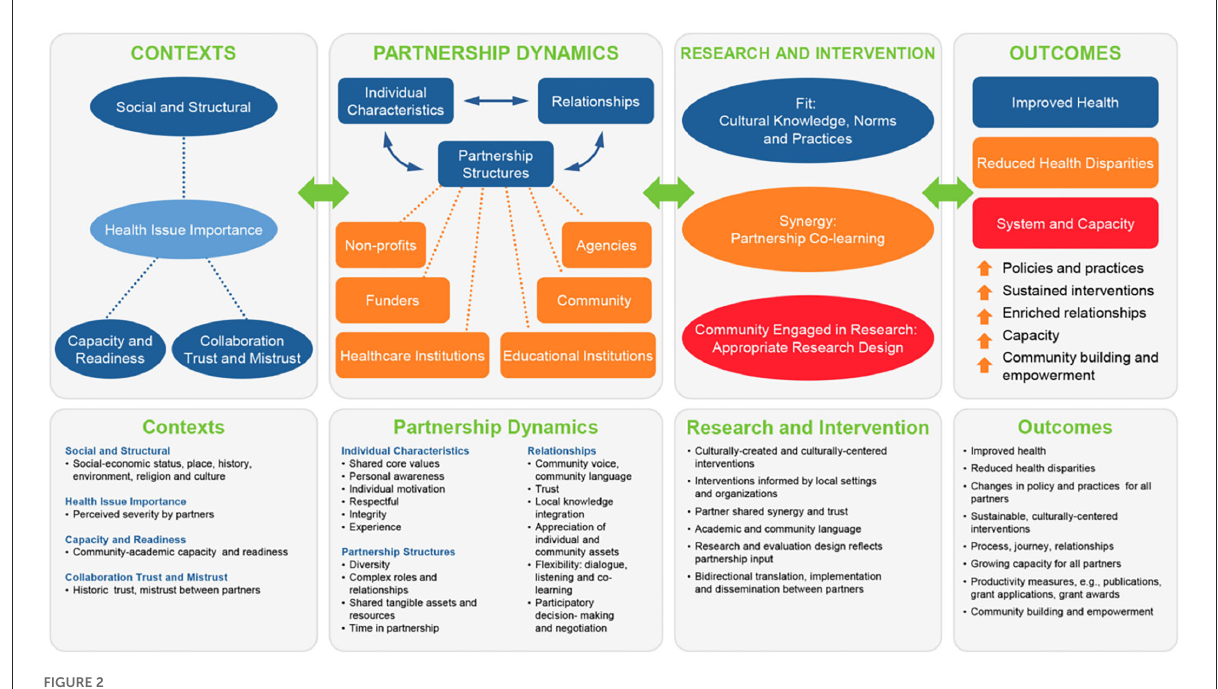
FIGURE2 RHCP CBPR conceptual model